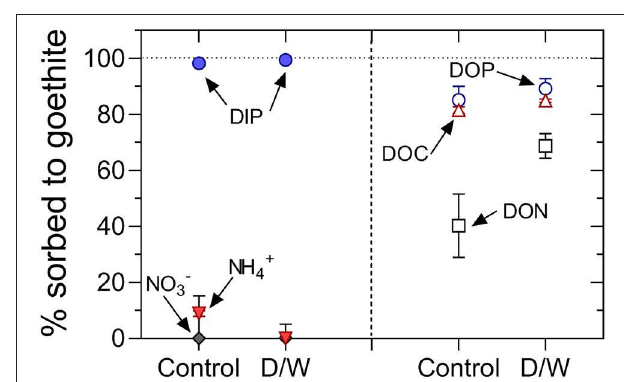
FIGURE 8 | Sorption of inorganic and organic C, N, and P in leachates to goethite. Data shown here are based on leachates from the Oe-Oa horizon collected after 19 weeks of incubation in the permanent moist control treatment and during rewetting following drought (D/W). Means and standard errors of four